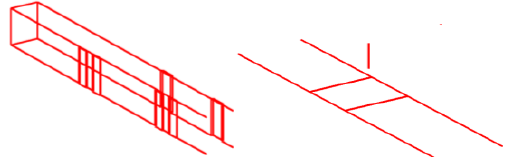
Figure 11. 3D wireframe models used for matching. Indoor model(left).Outdoor road and street post vector(right) .